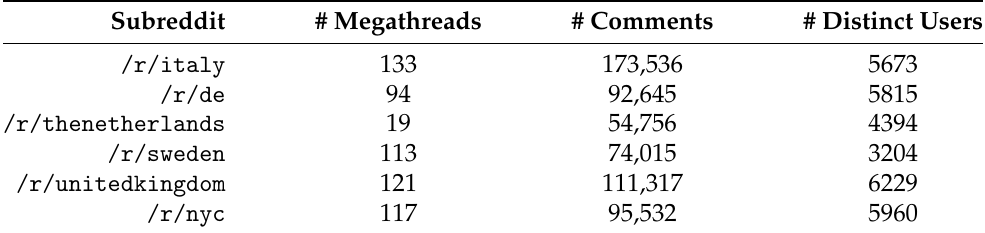
Table 2. Total number of megathreads, comments and distinct users for each subreddit related to COVID-19 (in the following, 2020 dataset or COVID dataset). # Megathreads